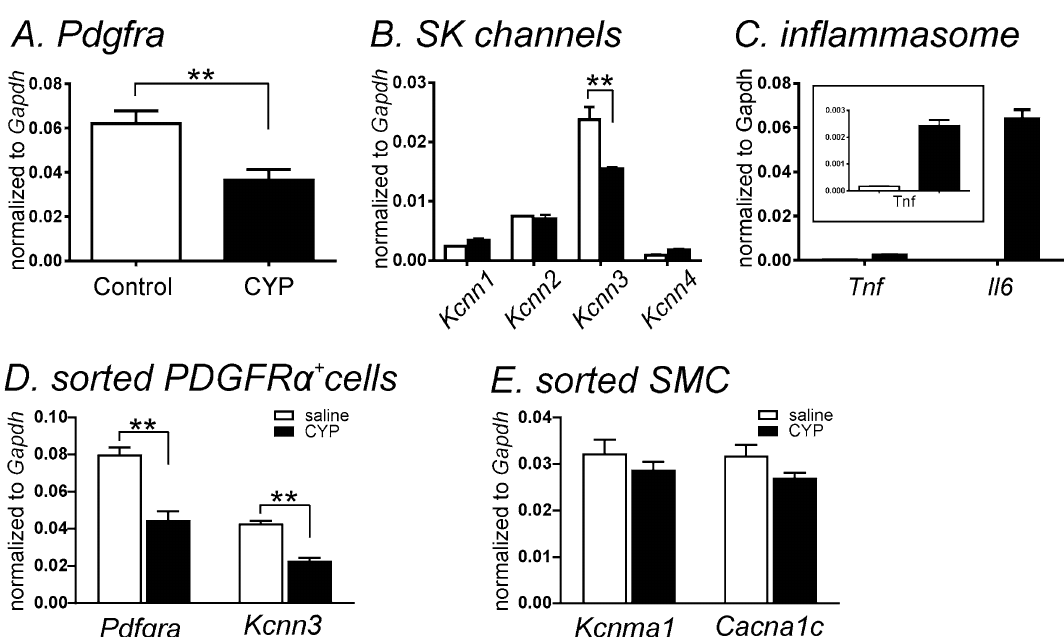
Figure 1. Quantitative analysis of transcripts in control and CYP-treated detrusor muscles. ( A ) Transcripts for Pdgfra in control and CYP-treated detrusor muscle. ( B ) Transcripts for Kcnn in control and CYP-treated detrusor muscle. ( C ) Transcripts for Tnf and Il6 in control and CYP-treated detrusor muscle. ( D ) Comparison of transcriptional expression of Pdgfra and Kcnn3 from sorted PDGFRα + cells in saline-injected (white bar) and CYP-treated detrusors. ( E ) Comparison of transcriptional expression of Kcnma1 and Cacna1c from sorted smooth muscle cells (SMC) in saline-injected (white bar) and CYP-treated detrusors. Expression of all transcripts was normalized to Gapdh . **Denotes P < 0.01 by unpaired t-test (n = 4 in all